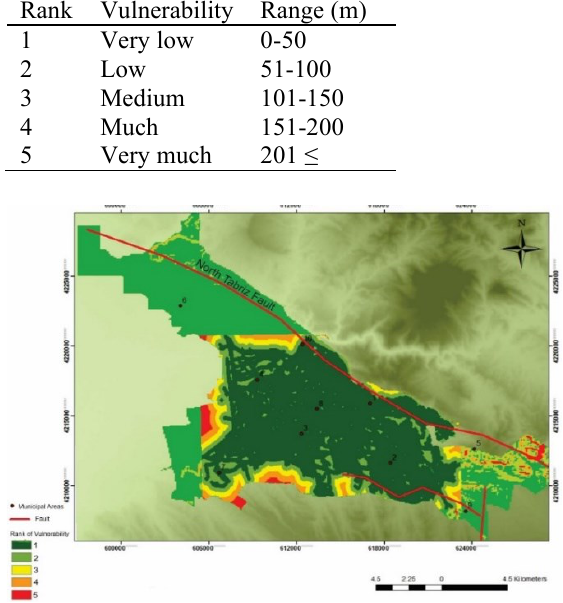
Fig. 9. Vulnerability map of Tabriz City based on distance from hazardous areas layer Table 10. Vulnerability and its ranking based on distance from open spaces and streets